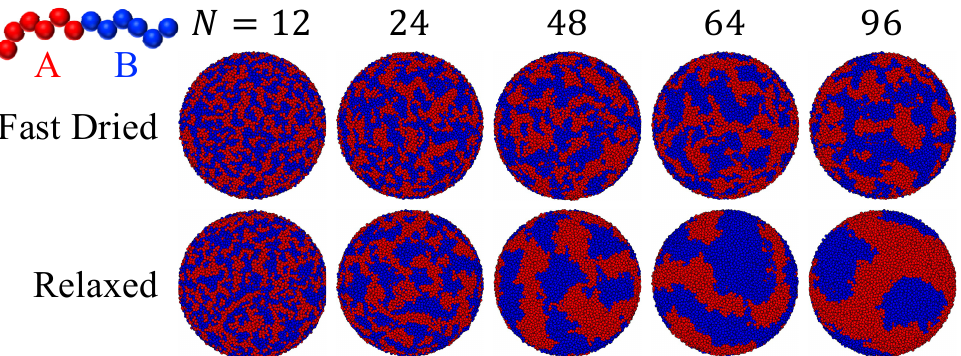
Figure 7. Effect of chain length ( N ) on particle morphology in drying droplets of diblock copolymer chains. For all the systems, (cid:101) AB = 2.0 (cid:101) and θ = 0 for both block A (red) and B (blue). The drying process lasts 5 × 10 3 τ , leading to particles in the top row with a radius of 24 σ . Relaxing each system for an additional period of 2 × 10 5 τ yields the particles in the bottom